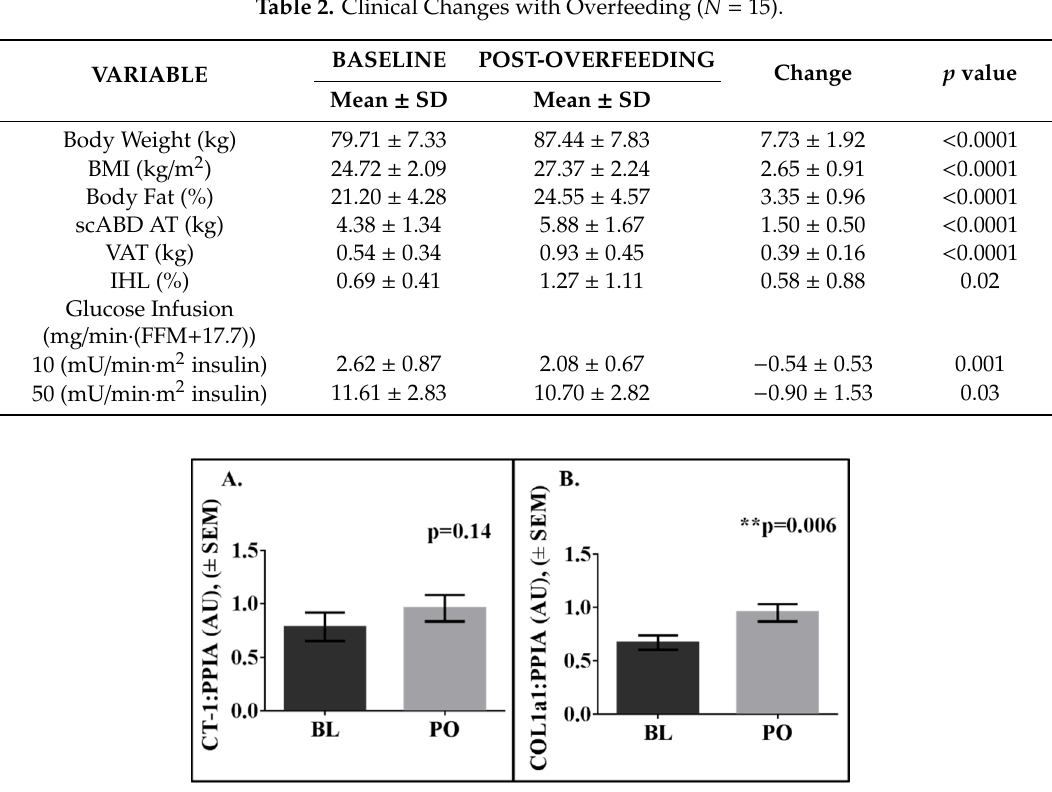
Figure 3. CT-1 is expressed in scABD AT in men, with no difference in expression between baseline and post-overfeeding. Subcutaneous abdominal (scABD) adipose tissue was collected from men ( N = 15). RNA was extracted, and ~200 ng was processed for CT-1 and COL1a1 mRNA analysis. Samples were run in triplicate, and expression levels were normalized to cyclophilin B (PPIB). Data are expressed as mean values ± SEM. (A) The difference in CT-1 expression between post-overfeeding and baseline is 0.17 ( p = 0.14). (B) The difference in COL1a1 expression between post-overfeeding and baseline is 0.28 ( p = 0.006).